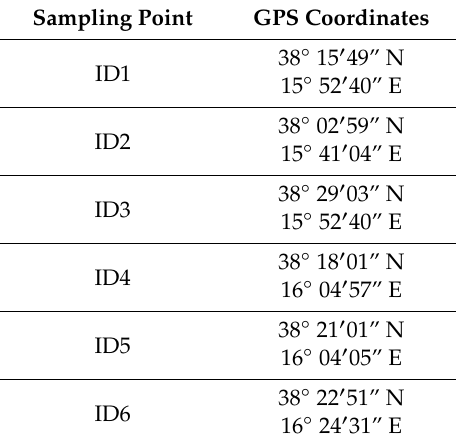
Table 1. The GPS coordinates of the sampling